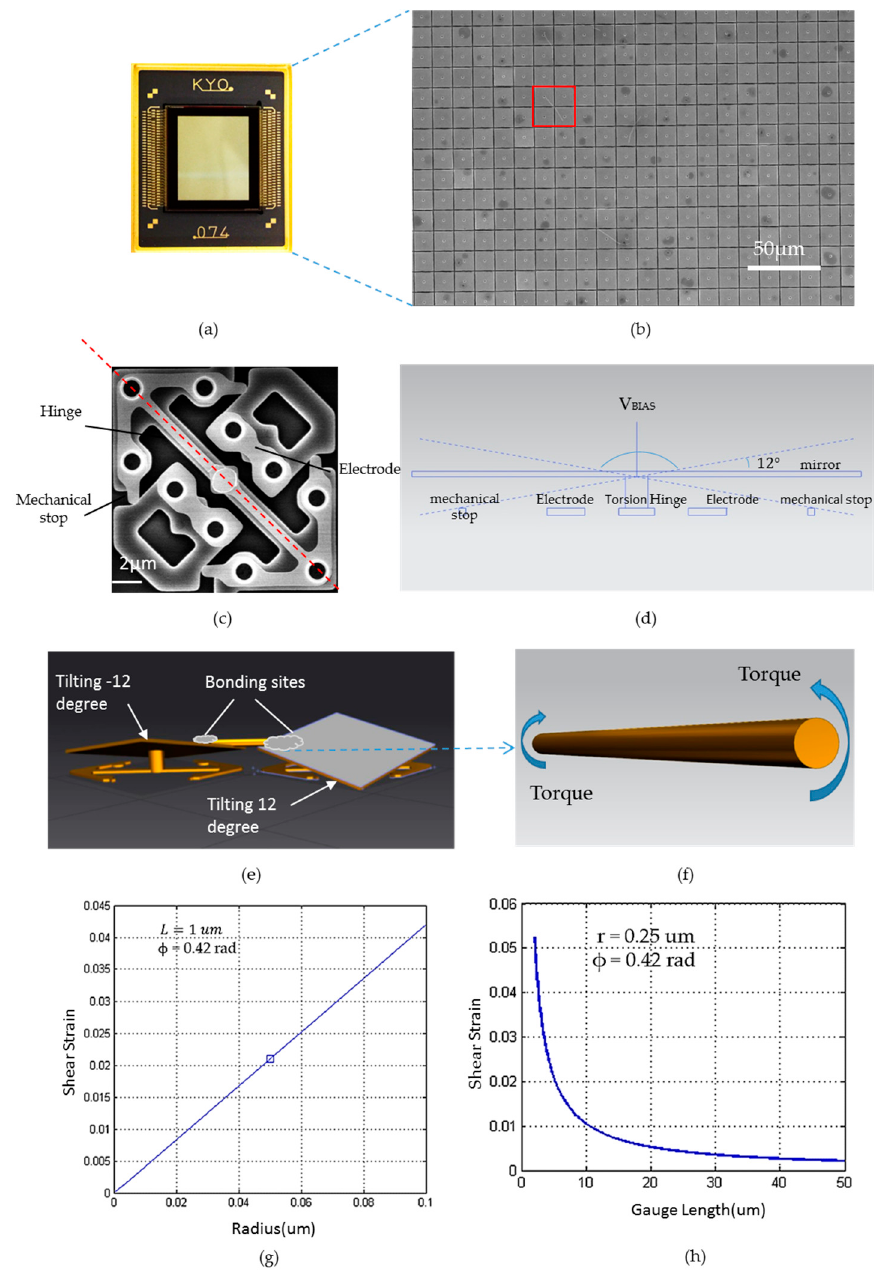
Figure 1. Scheme of the DMD-based torsional testing micromachine: ( a ) shows the DMD chip after removing the protection cover; ( b ) SEM image shows that millions of micromirror arrays are available on a single DMD chip, with one single nanowire (in red square) being clamped between two diagonally opposite micromirrors; ( c ) shows the micro-fabricated structure under a single micromirror, whose main components were torsion hinge and electrodes. Side view ( d ) shows how the electrostatic force between the mirror and the underneath electrodes actuate the micromirror. The schematic illustration ( e ) shows how two diagonal micromirrors tilting along the hinge can introduce the torsional straining on the nanowire clamped in-between ( f ). Graph ( g ) and ( h ) illustrate the relationship between shear strain and radius or gauge length.